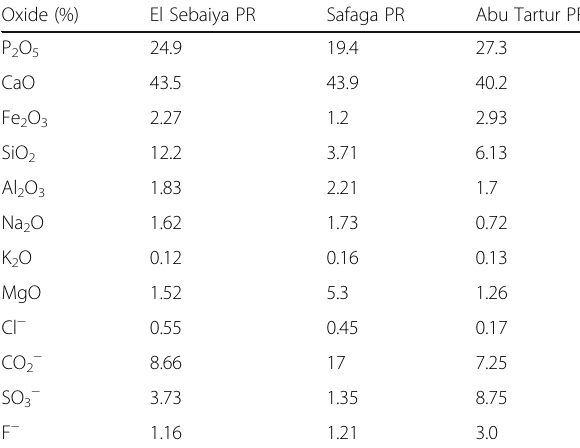
Table 2 Composition of phosphate rock in